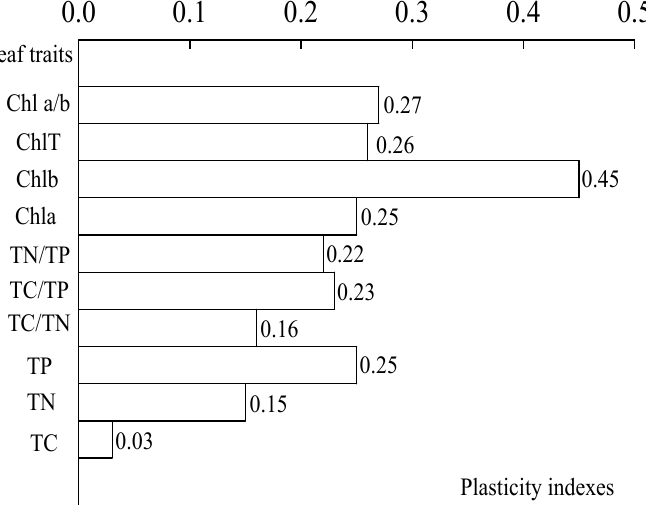
Figure 6. Plasticity indexes of different characteristics.